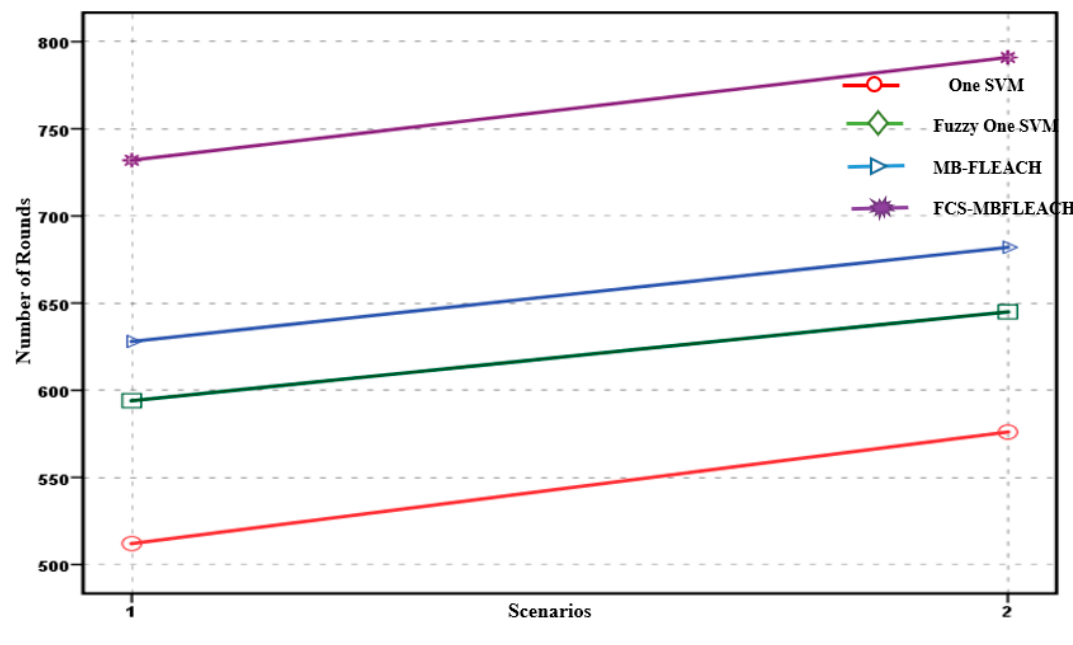
Figure 18. Half node death (HND) for all methods in two scenarios.